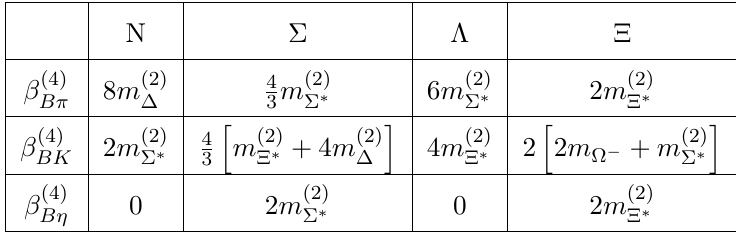
Table 6 . Coe(cid:14)cients of the O ( p 4 ) decuplet self-energy